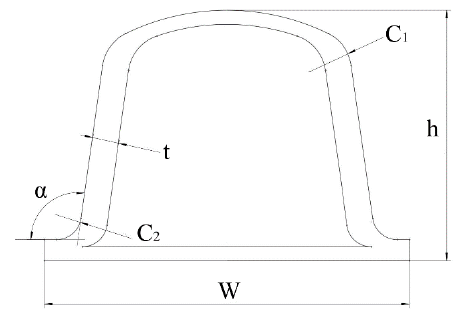
Figure 1. Waveform cross section of a bellows.